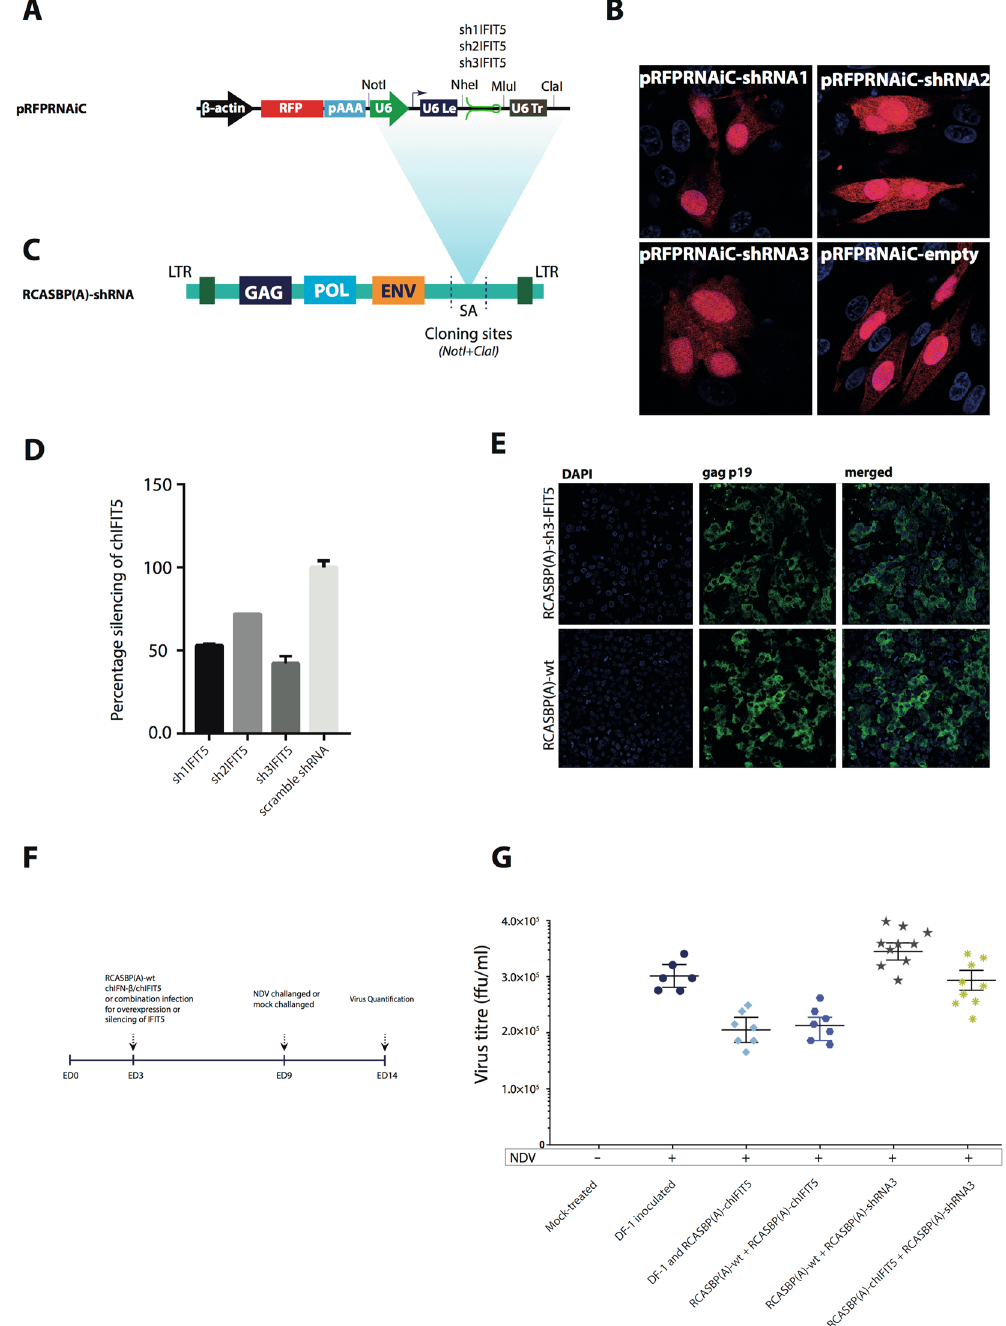
Figure 9. Silencing of endogenous chIFIT5 gene in transgenic chicken embryos and impact on the virus replication. ( A ) Three shRNA targeting exon 2 of chIFIT5 were cloned in pRFPRNAiC vector between NheI and MluI downstream to the chicken U6 promoter. ( B ) DF-1 cells were transfected with 500 ng of pRFPRNAiC-shRNA plasmid expressing each of the cloned shRNA or empty vector. The expression of RFP marker gene demonstrates the integrity of the constructs. ( C ) Transfer of validated shRNA (shRNA #3) cassette between NotI and ClaI sites in RCASBP(A) vector. ( D ) Silencing efficacies of all three chIFIT5-targeted shRNA compared to scrambled (non- targeting) shRNA. DF-1 cells, transfected with 500 ng of each of the plasmids, were used to extract total cellular RNA and the level of chIFIT5 gene silencing was monitored using qRT-PCR. ( E ) Retroviruses were rescued in DF-1 cells and stained for structural gag protein indicating the replication-competency of these retroviruses. ( F ) Infectious cells stably expressing pre-validated shRNA against chIFIT5 gene were inoculated in 3 days old chicken embryos and allowed to develop until 9 days post-embryonation when 100 FPUs of NDV were inoculated per transgenic egg and the quantification of the virus replication was performed on day 14 post-embryonation. ( G ) Quantitative analysis of viruses in NDV-infected and un-infected transgenic embryos expressing shRNA, wt chIFIT5 or shRNA- resistant chIFIT5. Each dot represents individual chicken embryo in all experimental